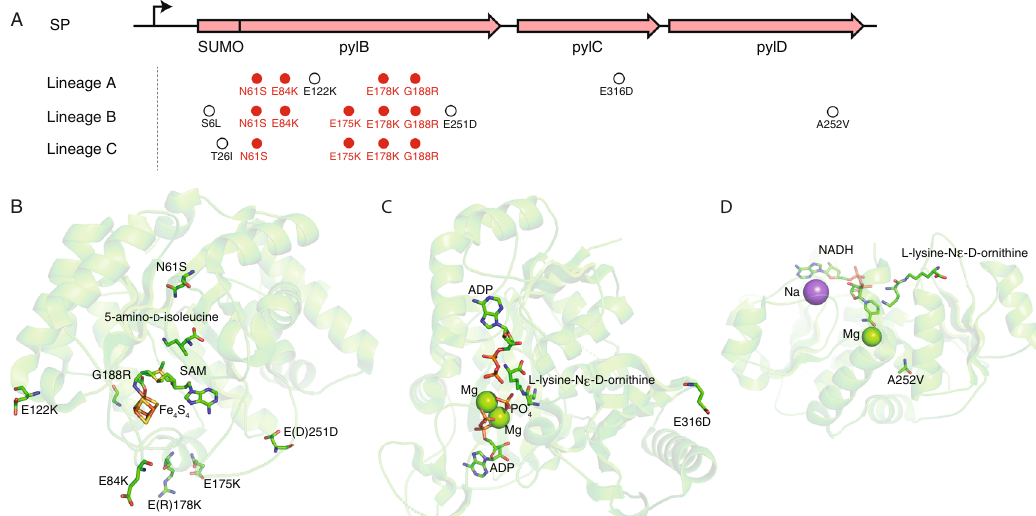
Fig. 2 Convergent mutations in the co-evolved pylBCD genes. A Locations of critical mutations identi fi ed in three subpopulations shown within the previously solved structures of M. barkeri B PylB (PDB: 3T7V), C PylC (PDB: 4FFP), and D PylD (PDB: 4J4B); amino acid substitutions were all found outside the enzyme active sites, with many PylB mutations resulting in increased cationic surface charge. Numbering scheme is based on the wild-type protein sequences of PylB, PylC, and PylD in Methanosarcina acetivorans . Speci fi cally, numerical labels for PylB refer to the WT PylB protein sequence and do not include the 104 amino acids added by the SUMO tag. Brackets indicate residues naturally occurring in M. barkeri proteins that have diverged from the M. acetivorans sequence. Mutations highlighted in red were observed to be convergent across multiple subpopulations (for further mutation analysis of subpopulations, see Supplementary Tables 2 and 3).